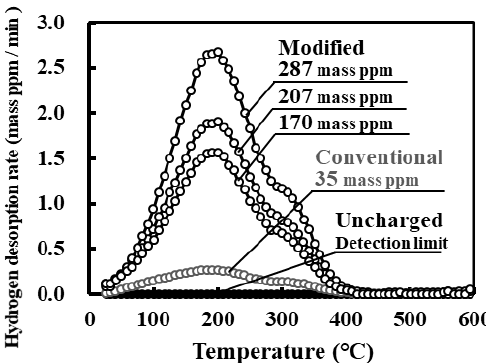
Figure 4. Hydrogen thermal desorption curves for uncharged specimen and specimens subjected to conventional and modified hydrogen charging. Values are the amounts of desorbed hydrogen.